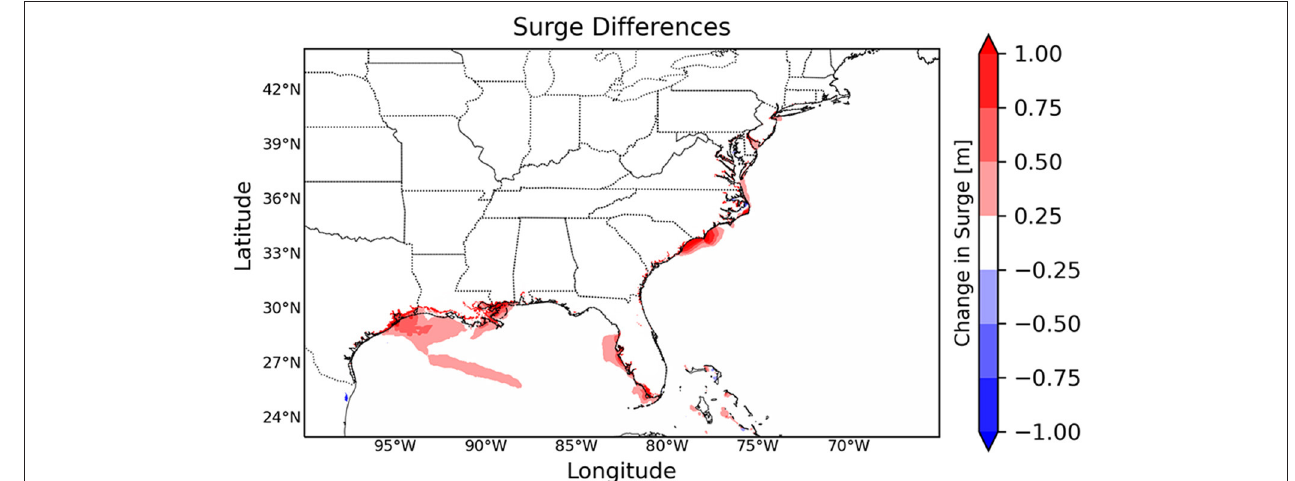
FIGURE 4 | Difference (PGW-CTRL) between maximum storm surge levels over the 21st century.